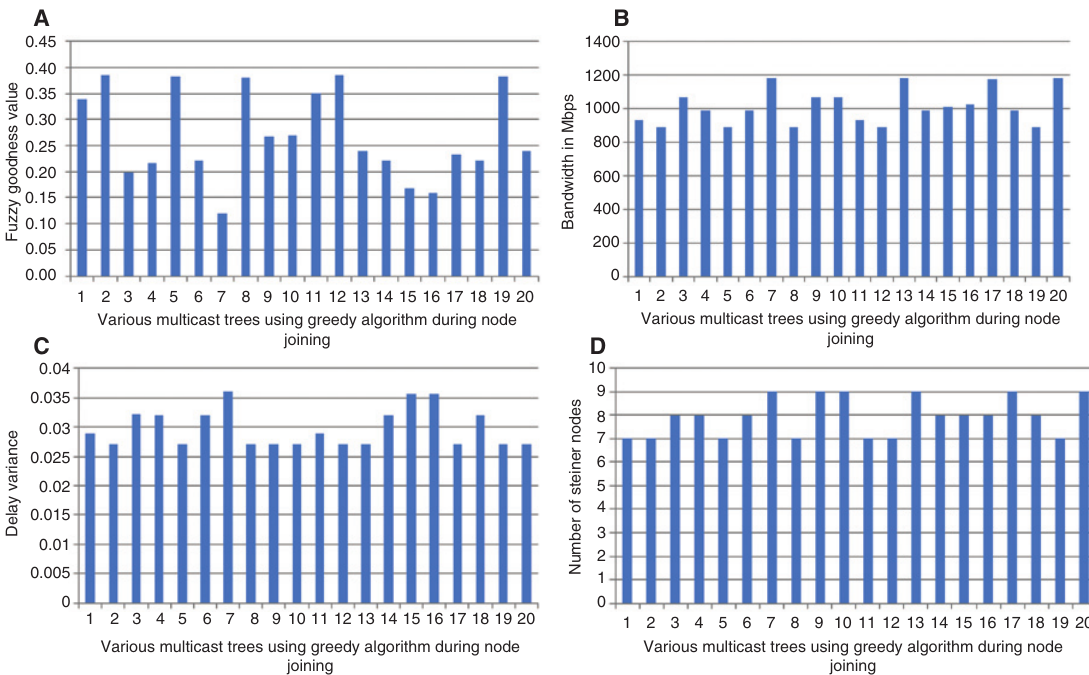
Figure 2. Effect of Fuzzy Membership Function on Various Multicast Trees Generated Using Greedy Algorithm When a Node Joins. function on various multicast trees generated using the greedy algorithm. It is clear from the graph that this fuzzy membership function provides a convenient method for combining conflicting objectives, including minimizing bandwidth, delay variance, and the number of Steiner nodes. Basically, three objective functions are combined using the fuzzy member function in Figure 2A. The higher the value of the fuzzy membership function, the better is the solution. It is indicated in Figure 2A that the best membership values are found for multicast trees 2, 5, 8, 12, and 19. All these multicast trees will give low bandwidth, low delay variance, and a minimum number of Steiner nodes (see Figure